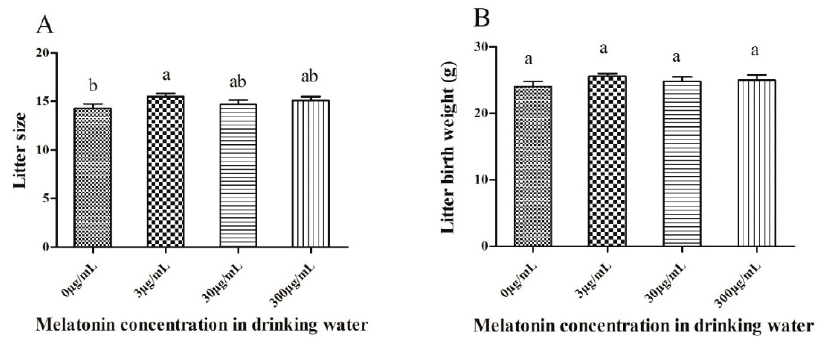
Figure 2. Effect of oral melatonin on litter size ( A ) and litter birth weights ( B ). Each value represents the mean ± SD from 10 replicates performed repeatedly. (a, b) indicate significant differences between the different groups ( p < 0.05).